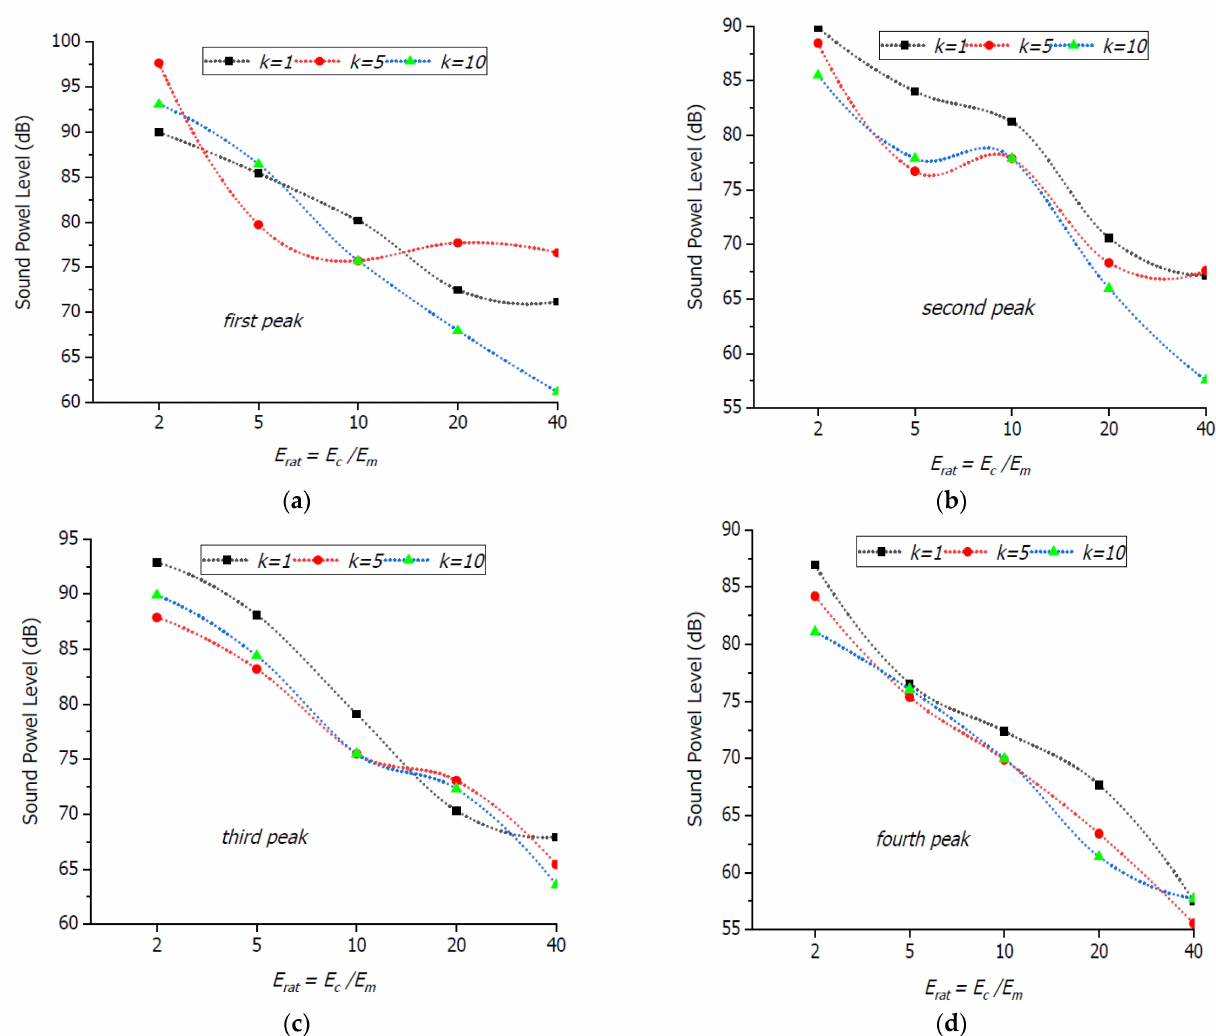
Figure 11. Influence on the sound power level peaks for different power-law indexes, k , and modulus ratio E rat ( a ) first peak, ( b ) second peak, ( c ) third peak, and ( d ) fourth